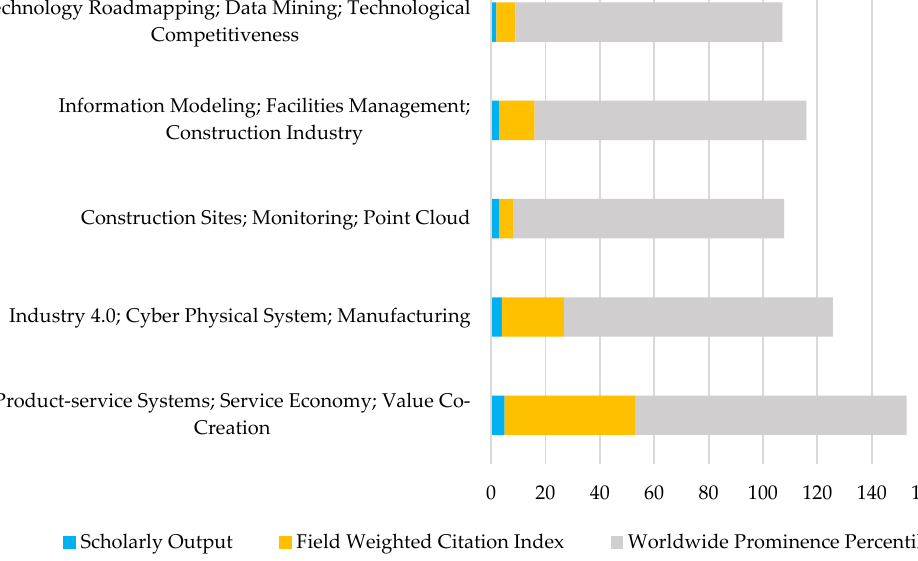
Figure 5. Top five topic clusters identified among the papers chosen for inclusion in this research. Ironically, it appears that construction industry academics have been leading the charge when compared to their peers in mining. Of the articles determined to be eligible for this study, only a handful directly relate to mining operations ( n = 4). While the number